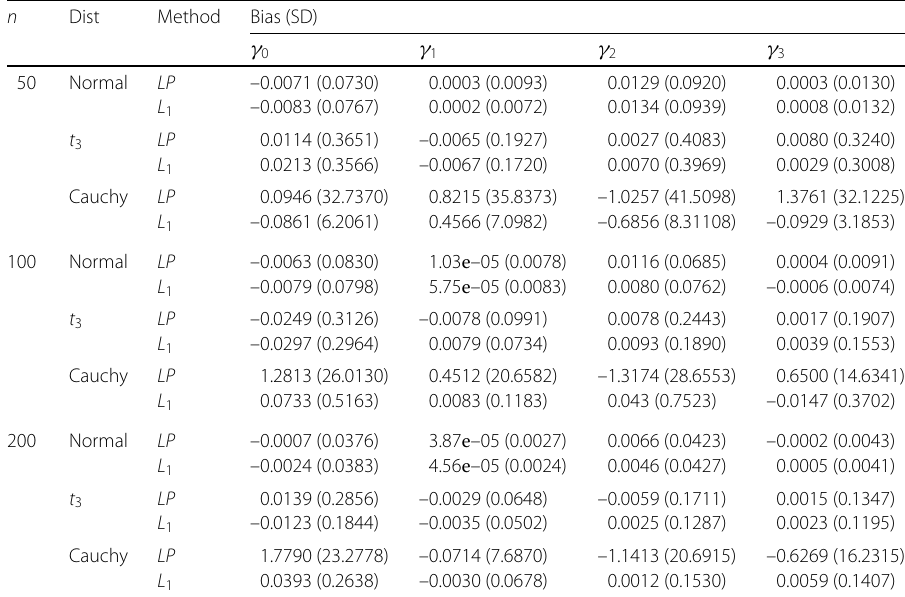
Table 1 Summary of bias and standard deviation over 1000 simulations